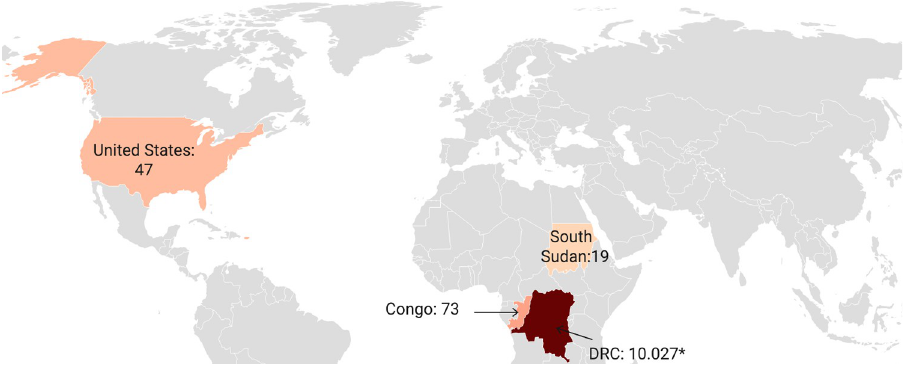
Fig 5. Number of confirmed, probable, and/or possible monkeypox cases between 2000–2009. [6,18,46,58,69] � Number reflects suspected cases, since as of the year 2000, the number of suspected cases was primarily reported by the DRC. (base layer of the map: https://datawrapper.dwcdn.net/SXvj7/1/).